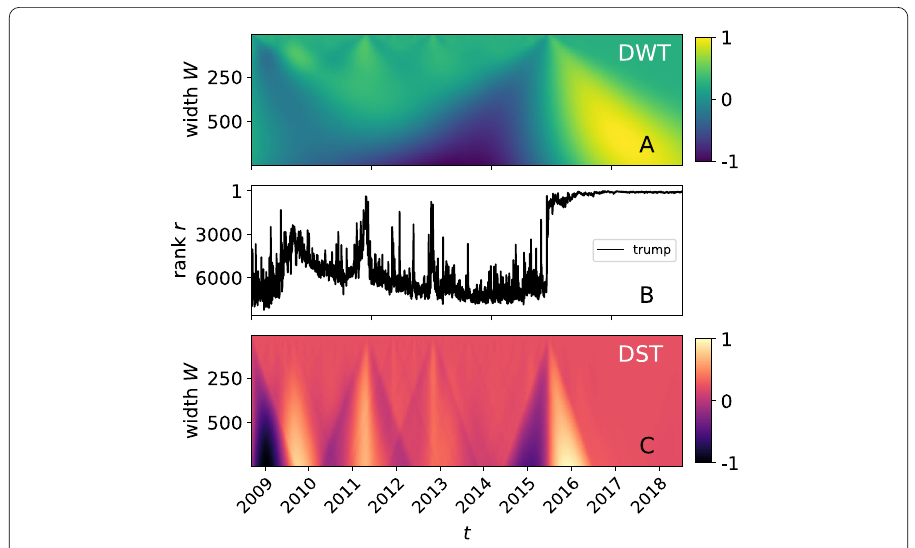
Figure 3 A comparison between the standard discrete wavelet transform (DWT) and our discrete shocklet transform (DST) of a sociotechnical time series. Panel ( B ) displays the daily time series of the rank r t of the word “trump” on Twitter. As a comparison with the DST, we computed the DWT of r t using the Ricker wavelet and display it in panel ( A ). Panel ( C ) shows the DST of the time series using a symmetric power shock, K ( S ) ( τ | W , θ ) ∼ rect ( τ ) τ θ , with exponent θ = 3. We chose to compare the DST with the DWT because